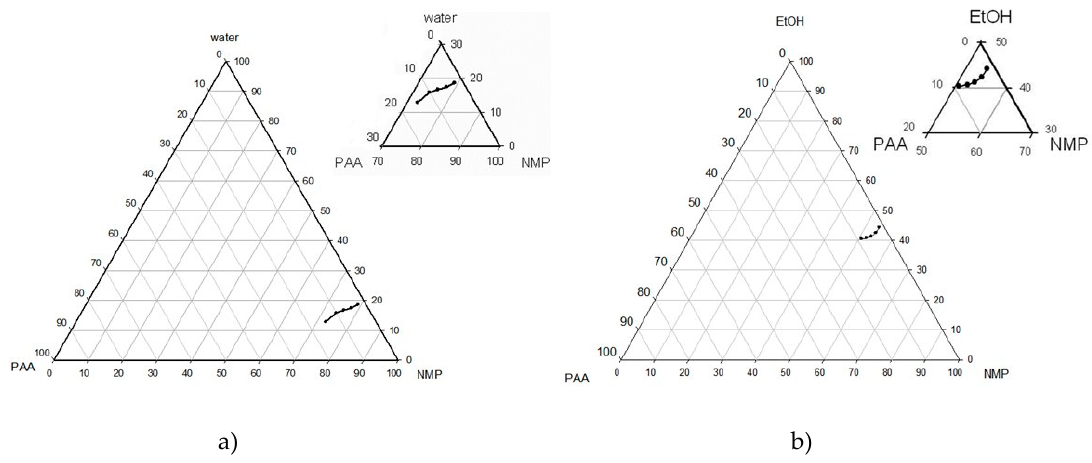
Figure 5. Phase diagram for PAA-NMP-H 2 O ( a ) and PAA-NMP-EtOH ( b ).